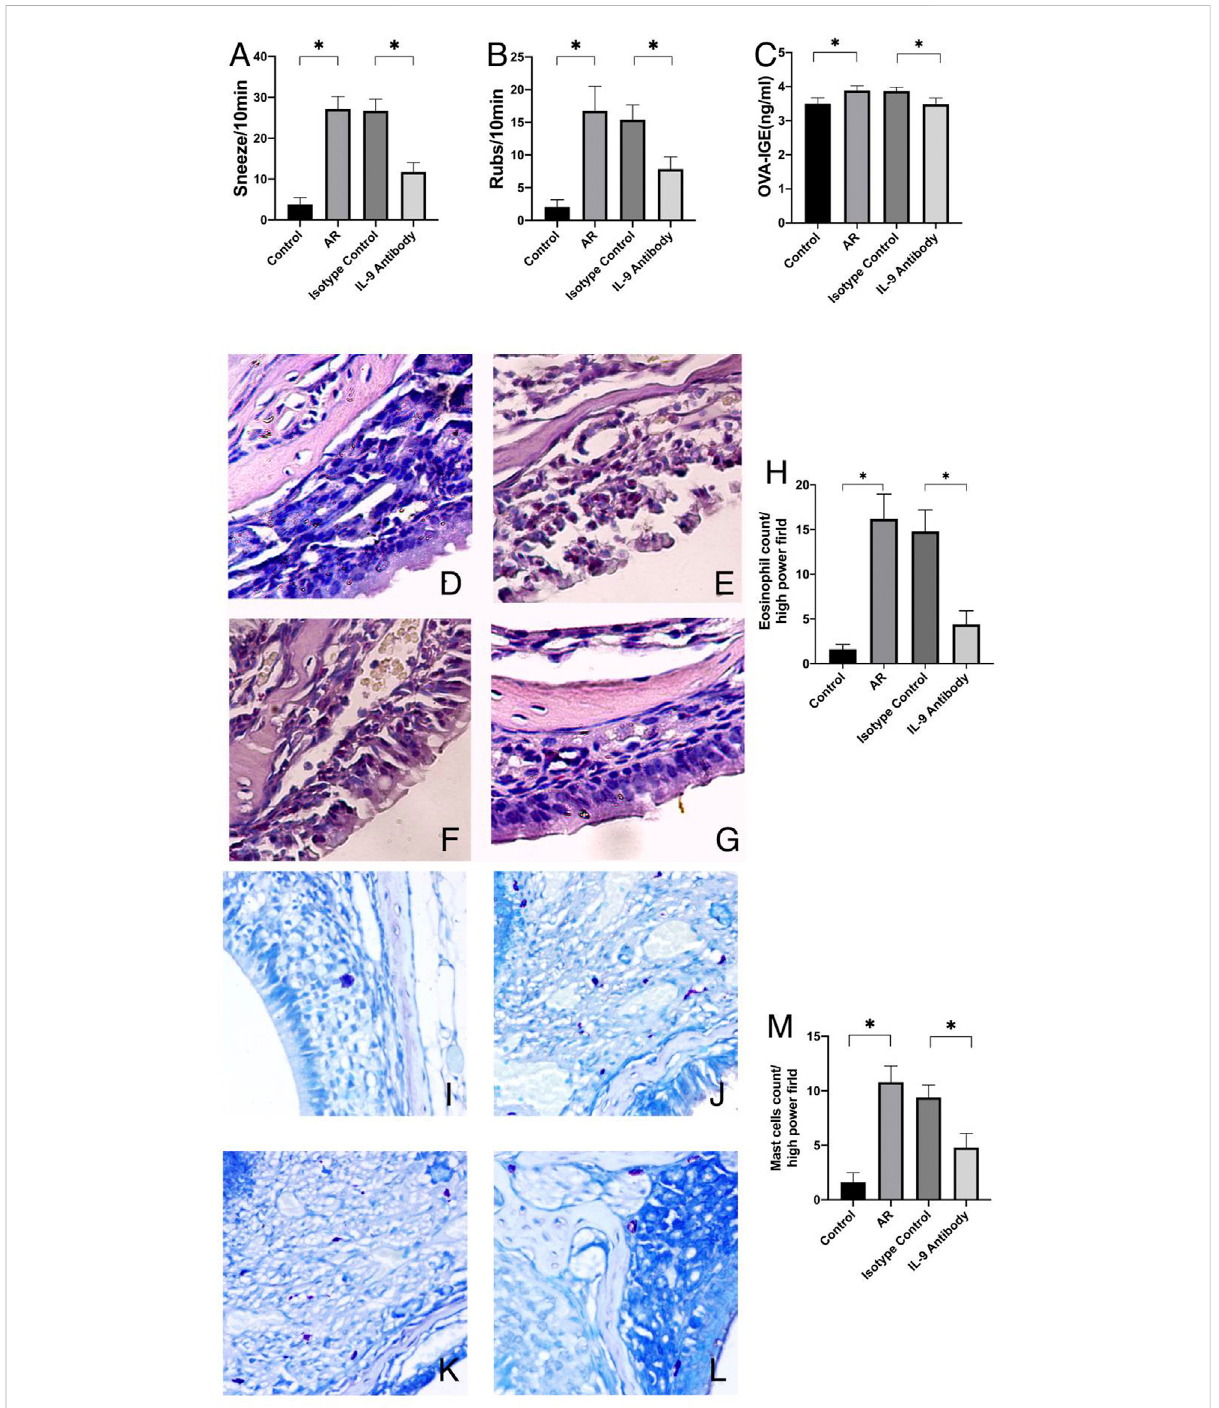
FIGURE 1 Symptoms and mucosal histology changed. ARwasthe allergic rhinitis group; IL-9Antibody was theIL-9 neutralizing antibody group;Isotype control was the homotypic control group. (A) and (B) was the symptoms of the mice. After using IL-9 neutralizing antibody, the frequency of nasal rubbing and sneezingdecreased.Everymousehasarubbingandsneezingcountofthe80mice.OnewayANOVA/Tukeywasusedforstatisticalanalysis.Allresultswere mean± SEM.* p < 0.05. (C) wasthedataofproteinexpressionofOVA-IgEinserumwhichwasmeasuredbyELISAofOVA-IgEofmice.Thedataarea representationof fi veindependentexperimentswithduplicatesamples.OnewayANOVA/Tukeywasusedforstatisticalanalysis.Allresultsweremean±SEM. * p < 0.05. (D – F) and (G) arepicturesofSiriusredstainedsectionunderoptical400Xmicroscope. (D) wasthecontrolgroup,Ewastheallergicrhinitisgroup,F was the homotypic control group, and G was the IL-9 neutralizing antibody group. H was the eosinophil counts of each group which counted by 400X microscope.TheaveragenumberofeosinophilsineachregionwascalculatedineachSiriusredstainedsection(n=5). (I – K) and (L) arepicturesofToluidine bluestainedsectionunderoptical400Xmicroscope. (I) wasthecontrolgroup, (J) wastheallergicrhinitisgroup,Kwasthehomotypiccontrolgroup,and (L) wastheIL-9neutralizingantibodygroup. (M) wasthemastcellcountsofeachgroupwhichcountedby400Xmicroscope.Theaveragenumberofmastcells ineachregionwascalculatedineachToluidinebluestainedsection( n =5).OnewayANOVA/Tukeywasusedforstatisticalanalysis.Allresultsweremean± SEM. * p <